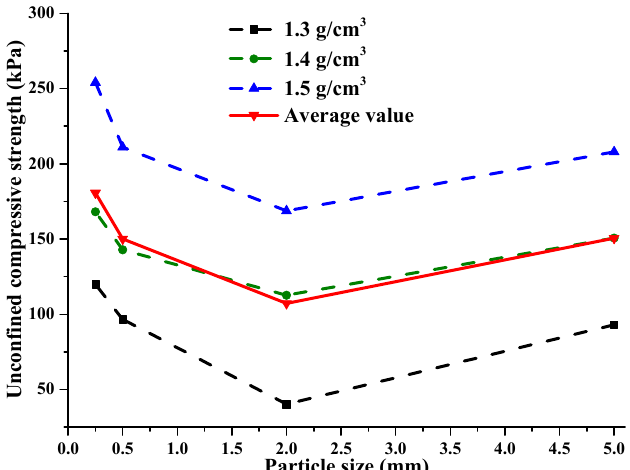
Figure 10. The fitting curve of particle size and UCS at different dry densities.